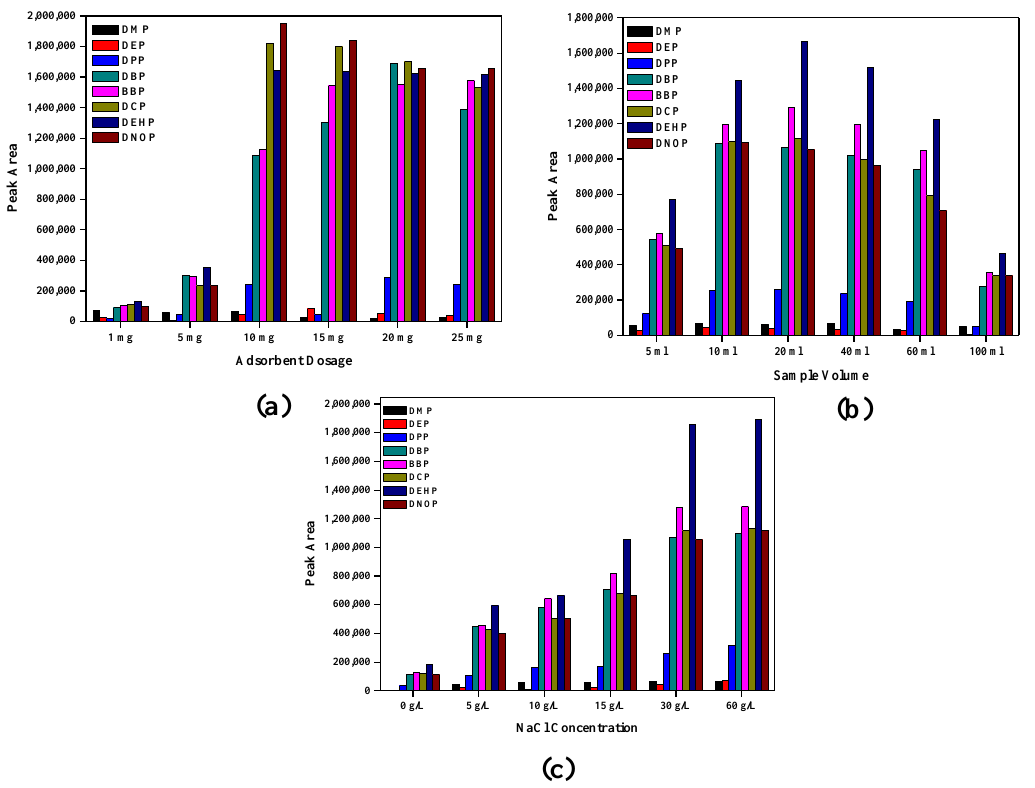
Figure 8. ( a ) Effect of adsorbent dosage; ( b ) effect of sample volume; ( c ) effect of NaCl concentration, for the extraction of targeted